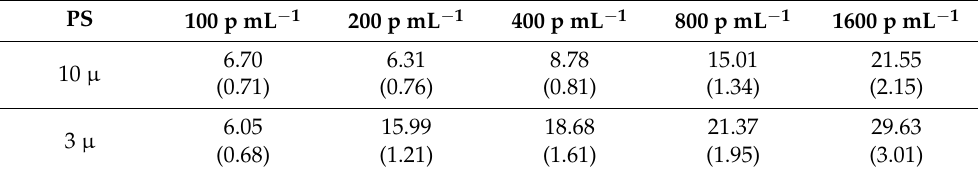
Table 1. Results of the MTT cell viability test after exposure to polystyrene (PS)-MPs (microplastics) for 24 h. Values are expressed in % of dead cells compared to control cells, in bracket standard deviation values.